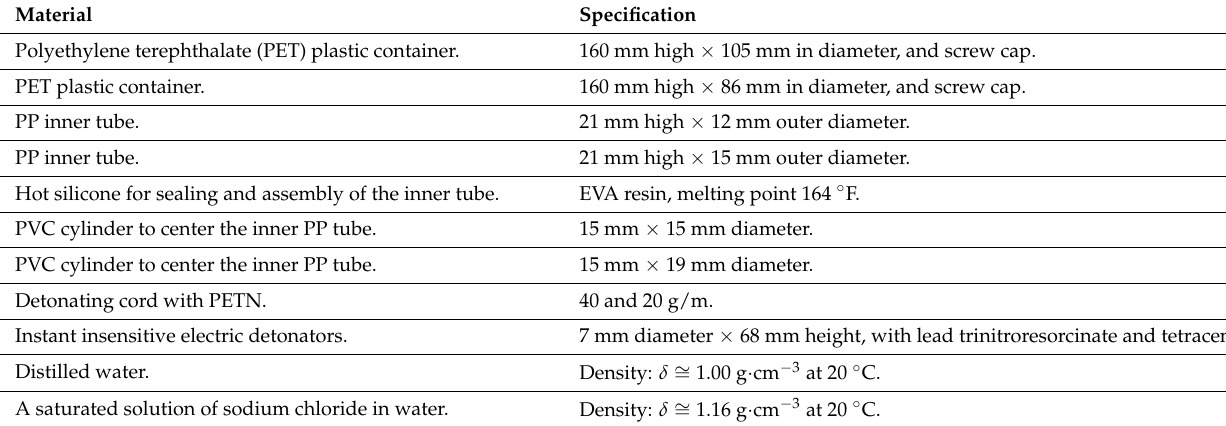
Table 3. Description of the materials